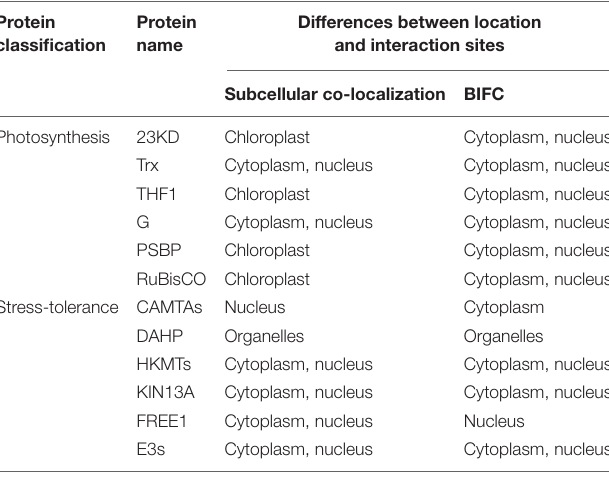
Protein Protein Differences between location